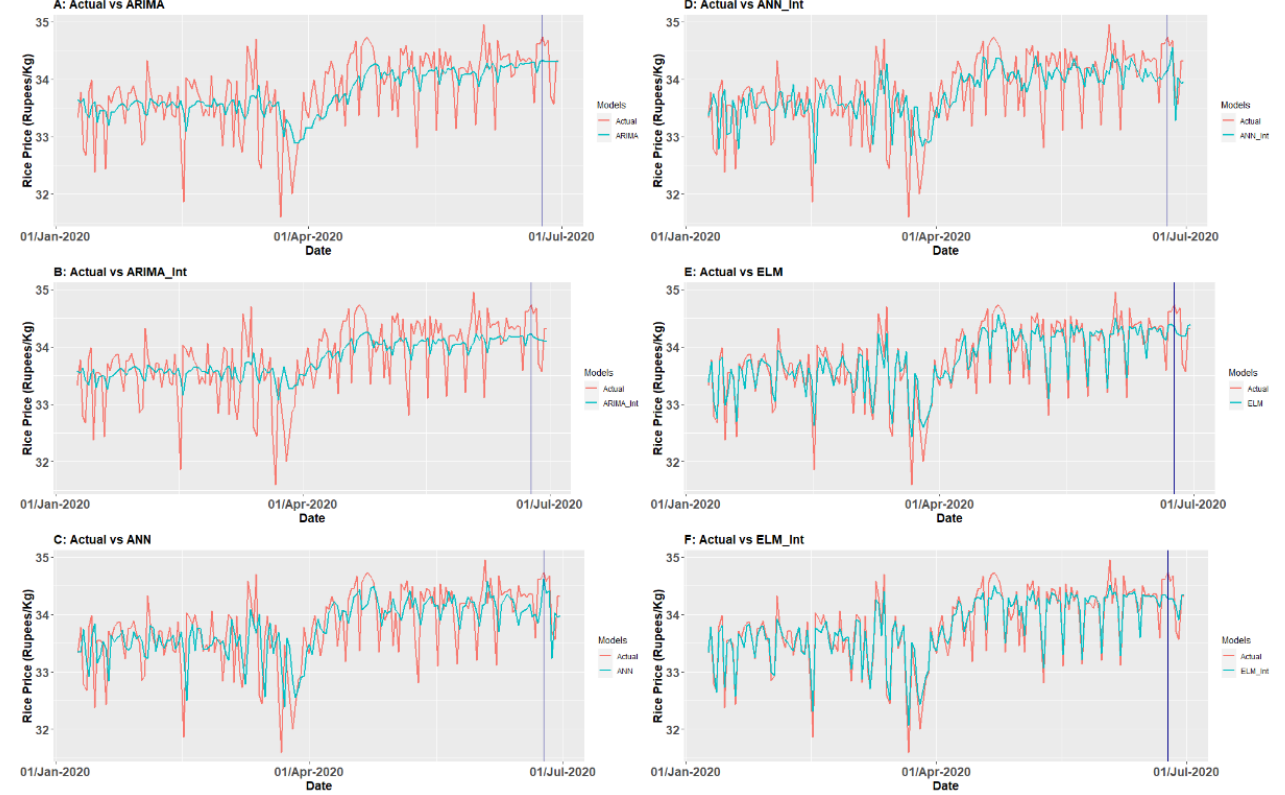
Figure 2. ( A ) Actual vs ARIMA fitted values, ( B ) actual vs ARIMA intervention fitted values, ( C ) actual vs ANN fitted values, ( D ) actual vs ANN intervention fitted values, ( E ) actual vs ELM fitted values, and ( F ) actual vs ELM intervention fitted values.